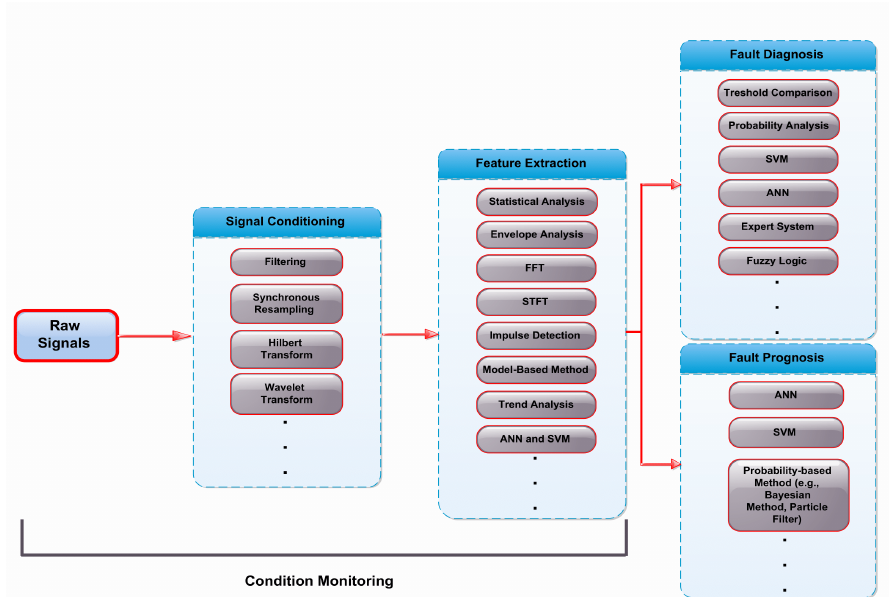
Figure 2. Signal processing and intelligent methods for Wind Turbine Condition Monitoring and Fault Diagnosis (WT-CMFD) and prognosis